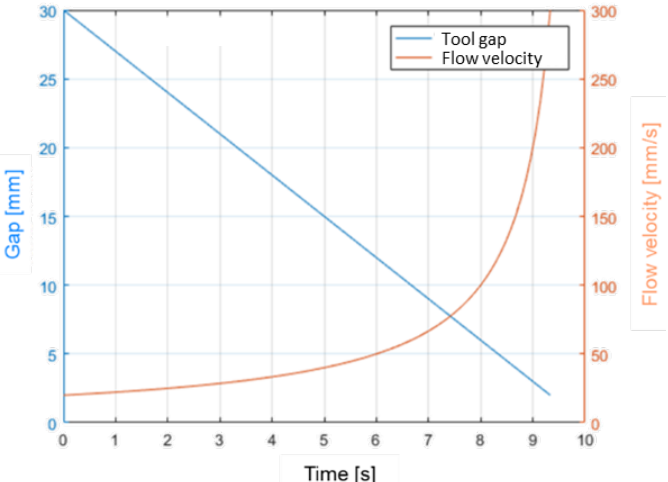
Figure 9. Gap height and flow velocity during compression molding .